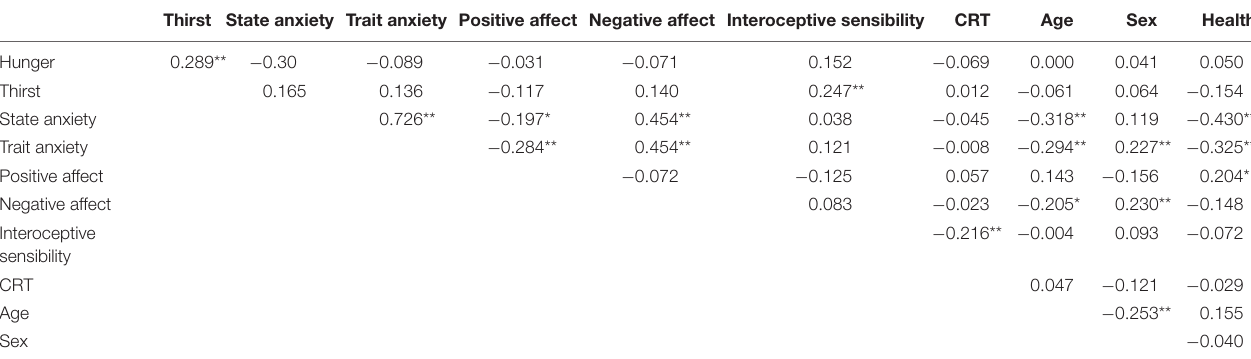
TABLE 2 | Pearson coefficients for all independent variables in vertical order: hunger, thirst, state anxiety, trait anxiety, positive affect, negative affect, interoceptive sensibility, Cognitive Reflection Task score (regular), age, sex (male = 1, female = 2), current health (* p < 0.05; ** p < 0.01). Thirst State anxiety Trait anxiety Positive affect Negative affect Interoceptive sensibility CRT Age Sex Health